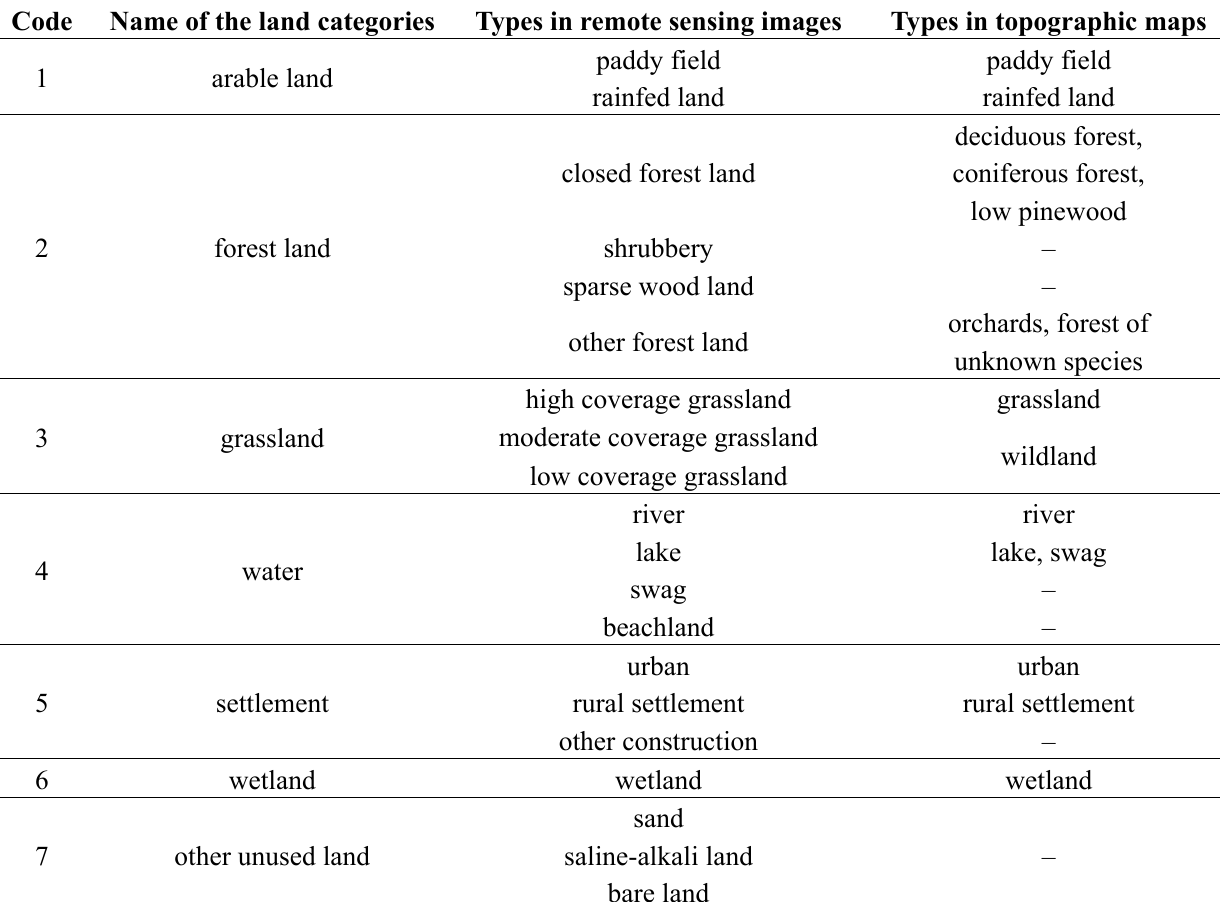
Table 1. Detailed classification system for land-use